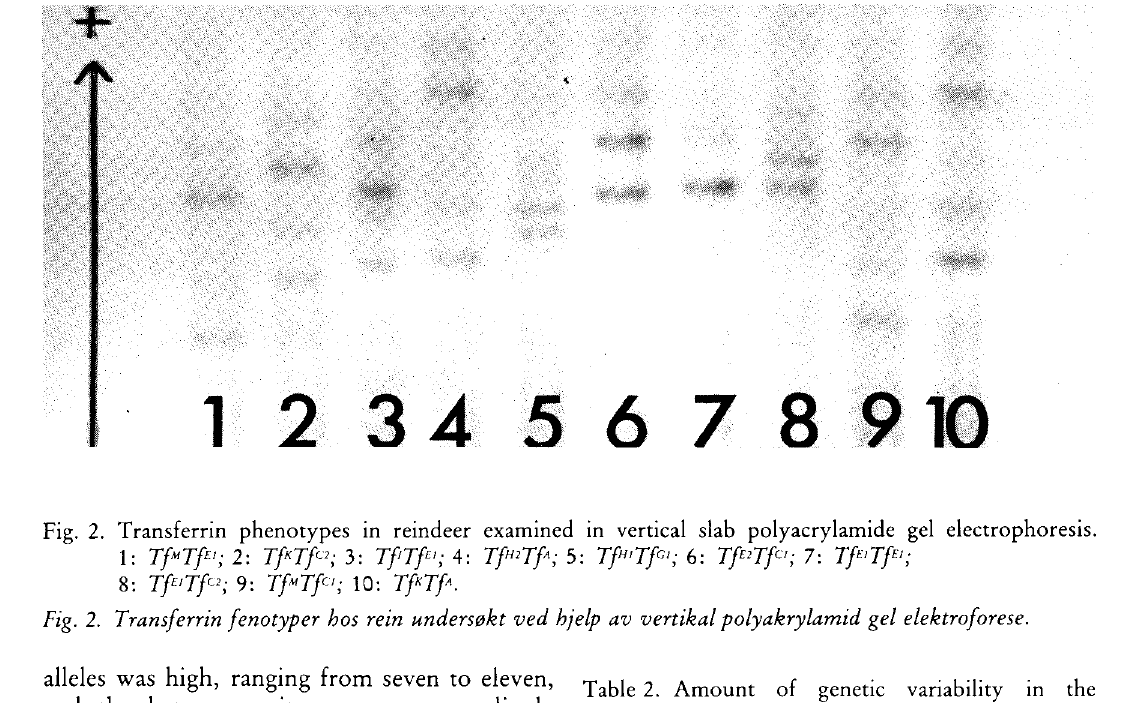
Table 2. Amount of genetic variability in the transferrin locus in Scandinavian reindeer populations. Tabell 2. Grad av genetisk variasjon i